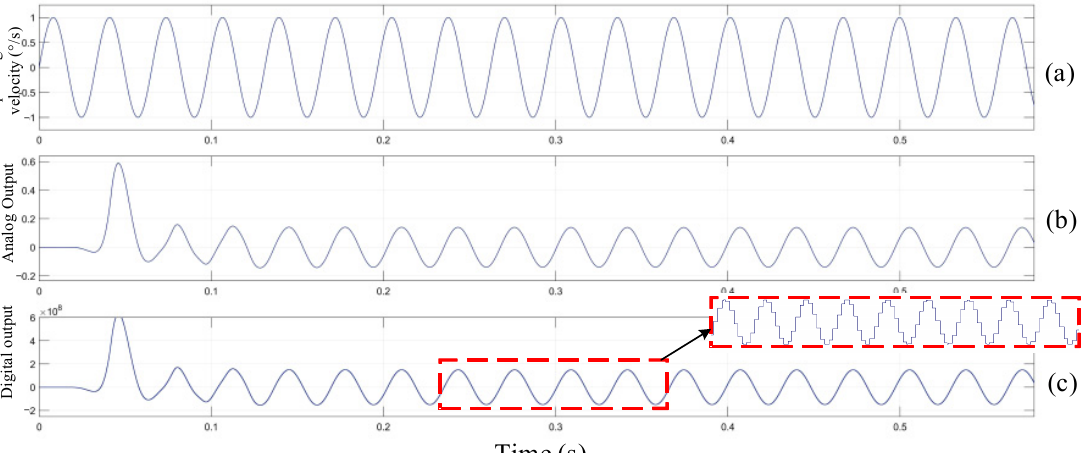
Figure 9. Sense circuit input and output simulation diagram: ( a ) Input angular velocity; ( b ) Analog output; ( c ) Digital output.